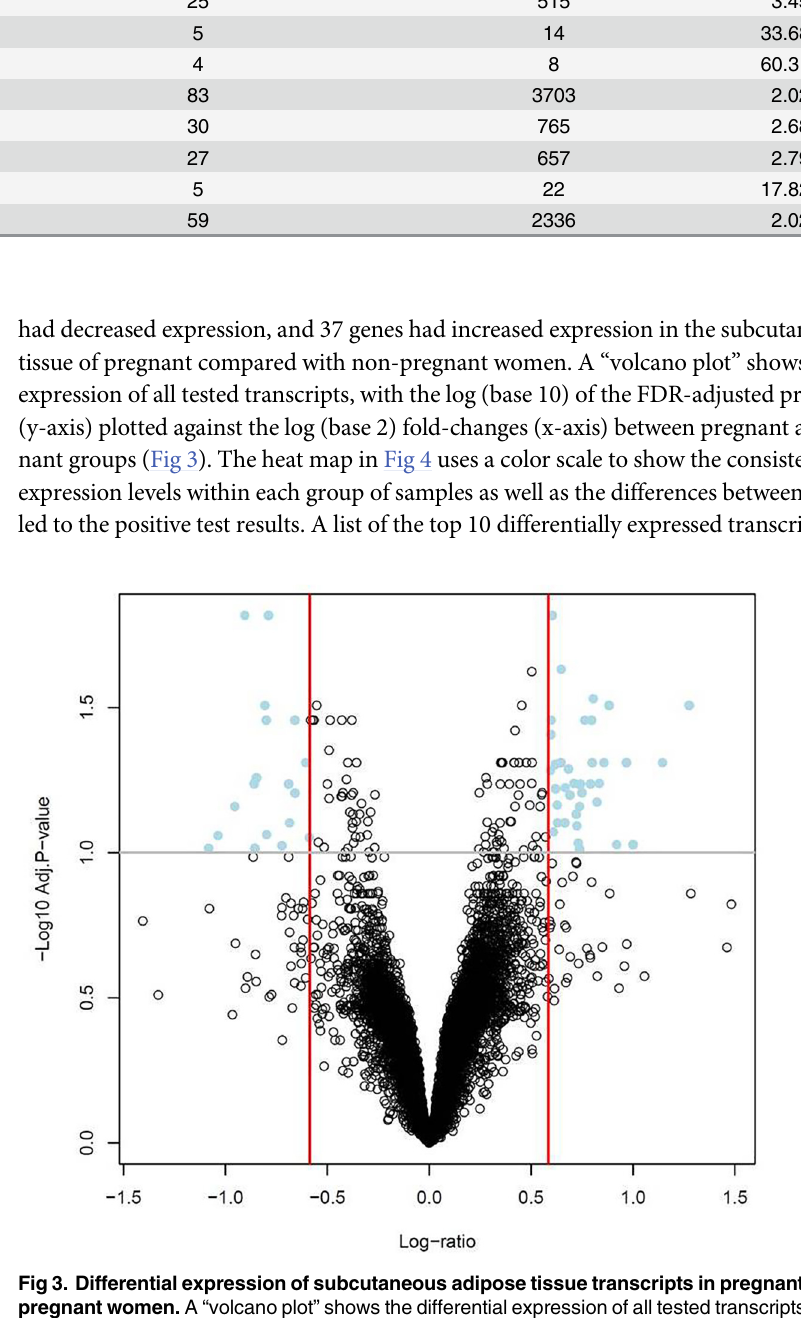
Fig 3. Differential expression of subcutaneous adipose tissue transcripts in pregnant vs. non- pregnant women. A “ volcano plot ” shows the differential expression of all tested transcripts, with the log (base 10) of the FDR-adjusted probability values (y-axis) plotted against the log (base 2) fold-changes (x- axis) between pregnant and non-pregnant groups.